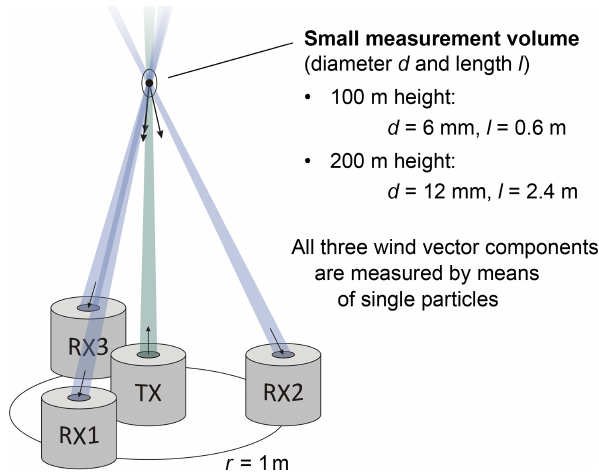
Figure 1. Principle of the novel bistatic lidar consisting of one trans- mitting unit (TX) and three receiving units